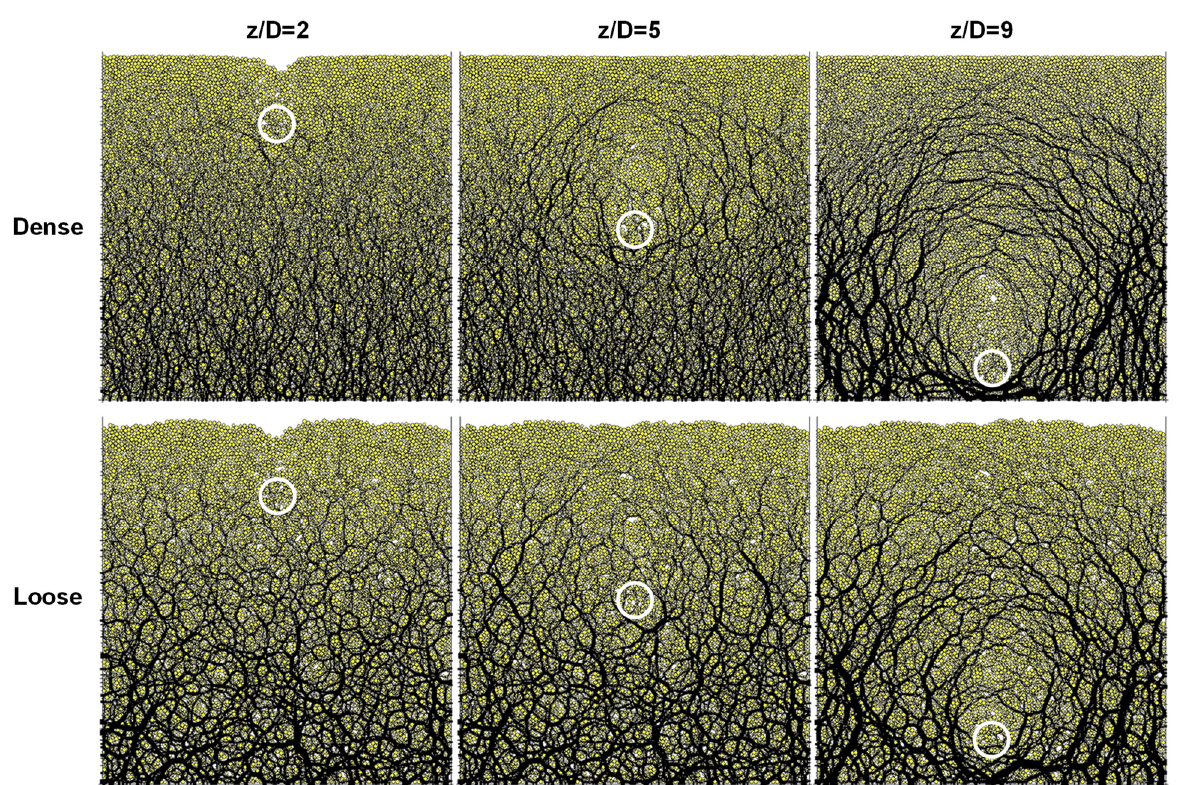
Figure 4. Contact force chains after dissolution. Force chain thicknesses reflect the force magnitude and are equally scaled for all cases. The white circles indicate the original location of dissolvable inclusions. Notice large local porosity next to strong force chains. Case: hindered rotation HR = 40%.